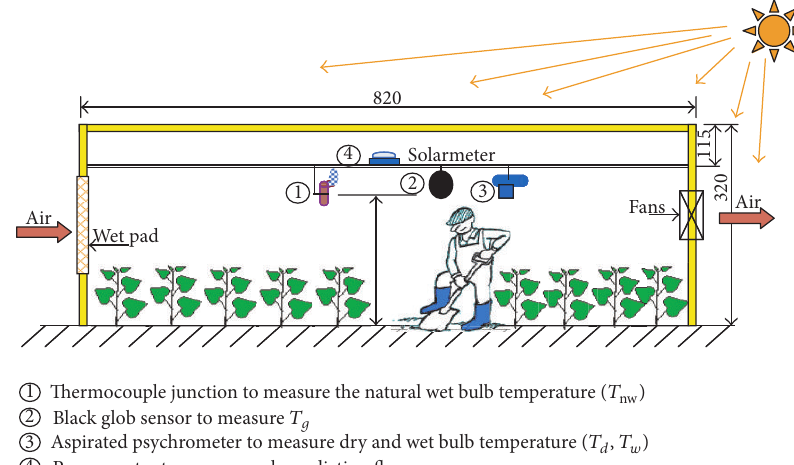
Figure 1: Layout dimensions (in cm) and locations of the instruments used to measure the required environmental parameters in the greenhouse.